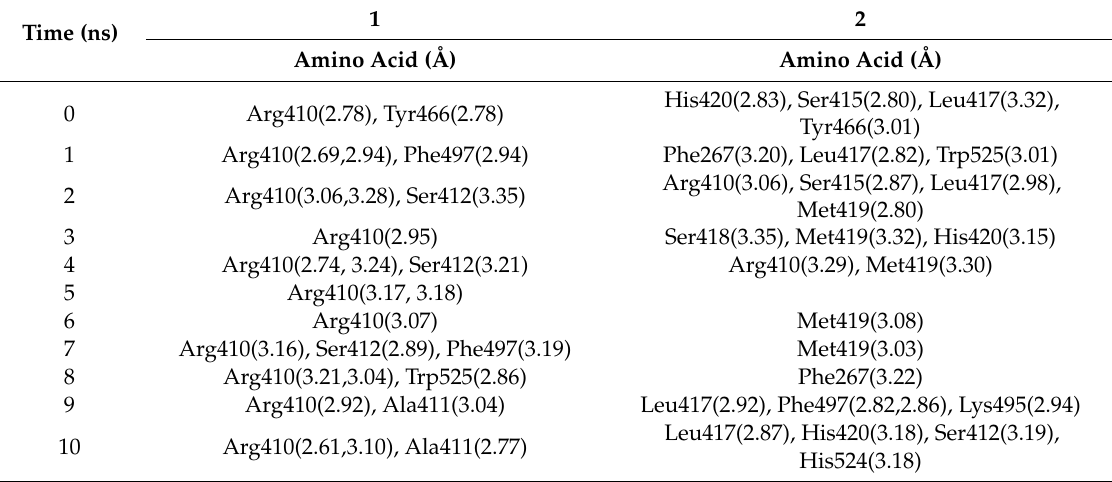
Figure 4. Superpositions of inhibitors 1 ( A ) and 2 ( B ) against sEH for 1 ns (red: 0, orange: 1, yellow: 2, green: 3, forest green: 4, cyan: 5, blue: 6, conflower blue: 7, purple: 8,magenta: 9, and black: 10 ns). The potential ( C ), RMSD ( D ), and hydrogen bond numbers ( E , F ) of 1 and 2 with sEH. The distance ( G , H ) of compounds 1 and 2 with key amino acids, respectively. Table 3. Hydrogen bond analysis of the inhibitors with sEH at 1-ns intervals for 10 ns.